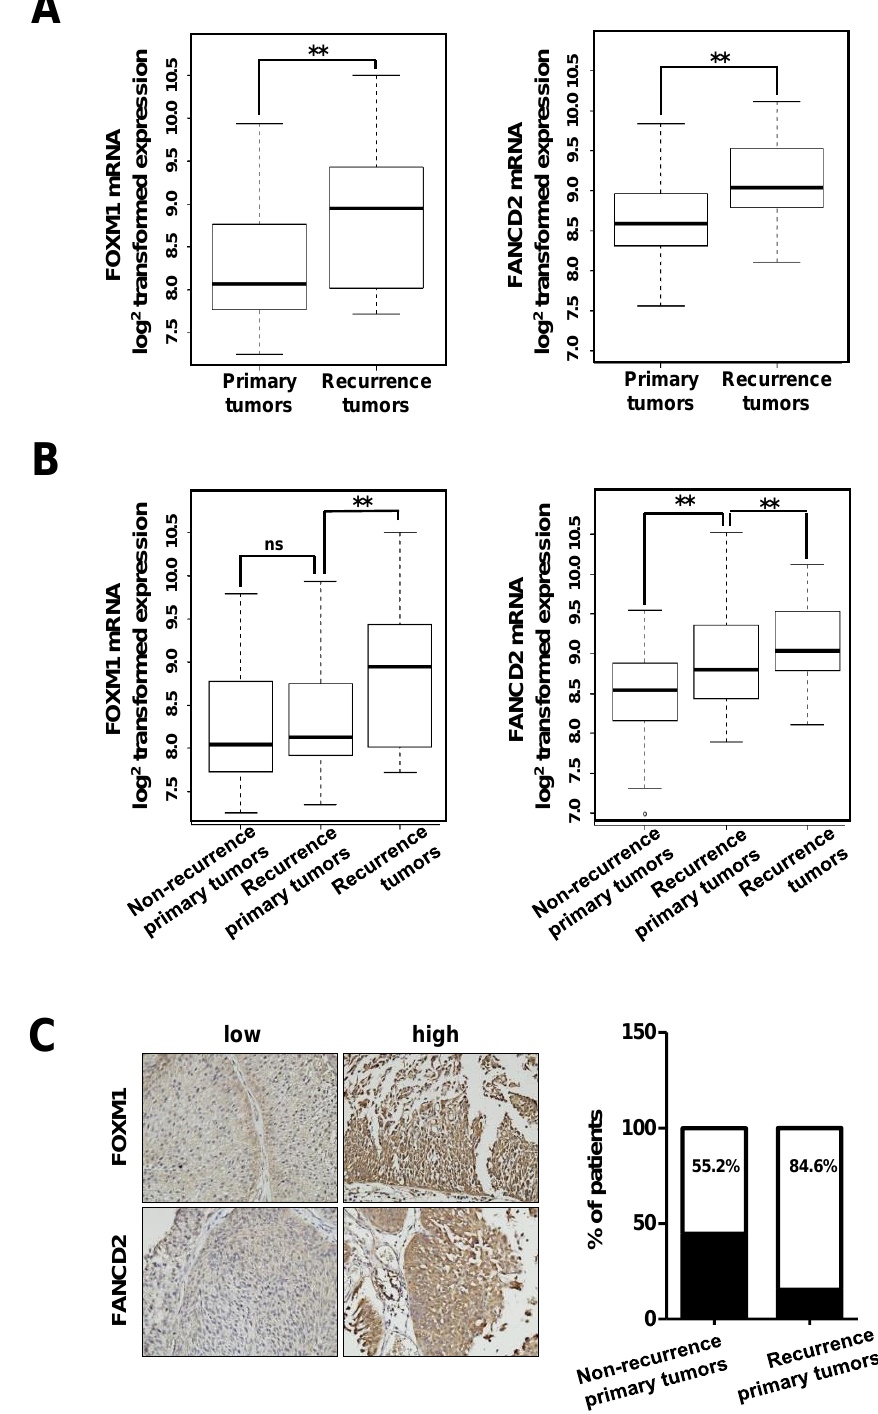
Figure 6. Expression of FOXM1 in NMIBC tissues. ( A ) Boxplot for two NMIBC patient groups (primary and recurrent tumor groups). ( B ) Boxplot for three NMIBC patient groups (nonrecurrent primary, recurrent primary, and recurrent tumor groups) . ( C ) RFS (Recurrence free survival) of FOXM1 expression levels in two independent NMIBC cohorts. (**, p < 0.01; and ns, not